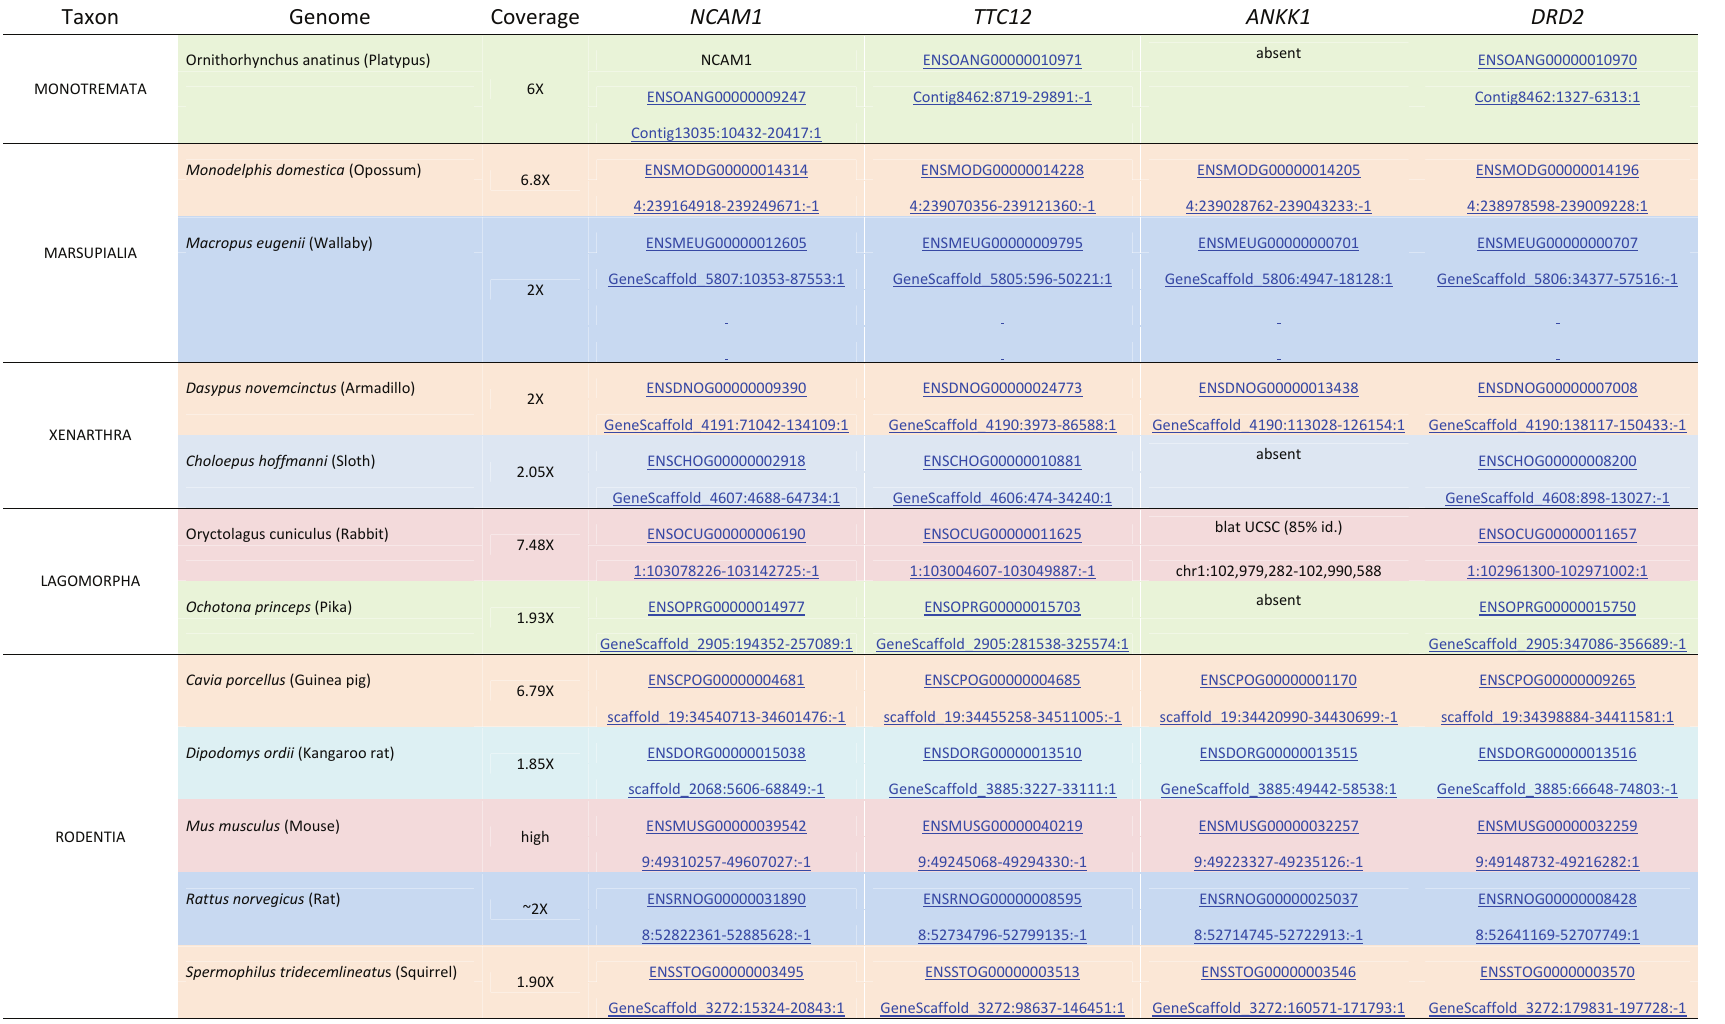
Table S1 (cont). Orthologues of genes in the NTAD cluster in 47 available vertebrate genomes, showing accession number and location.